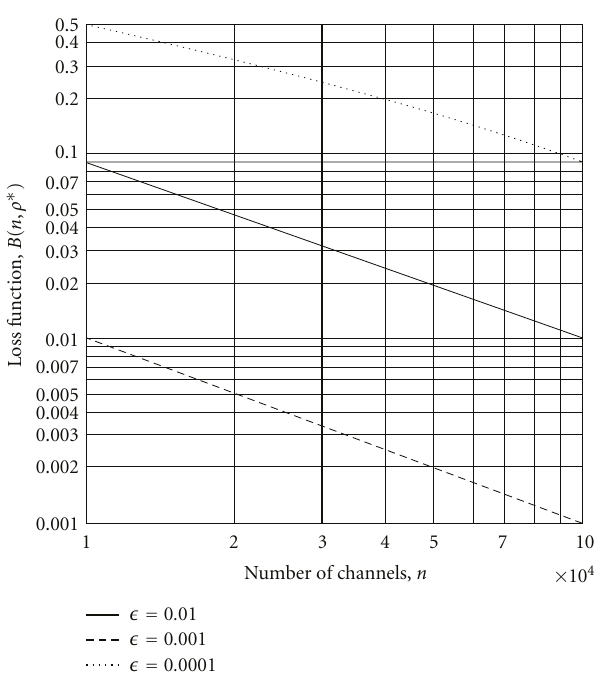
Figure 2: The behavior of losses function B ( n , ρ ∗ ) according to di ff erent values of (cid:2)